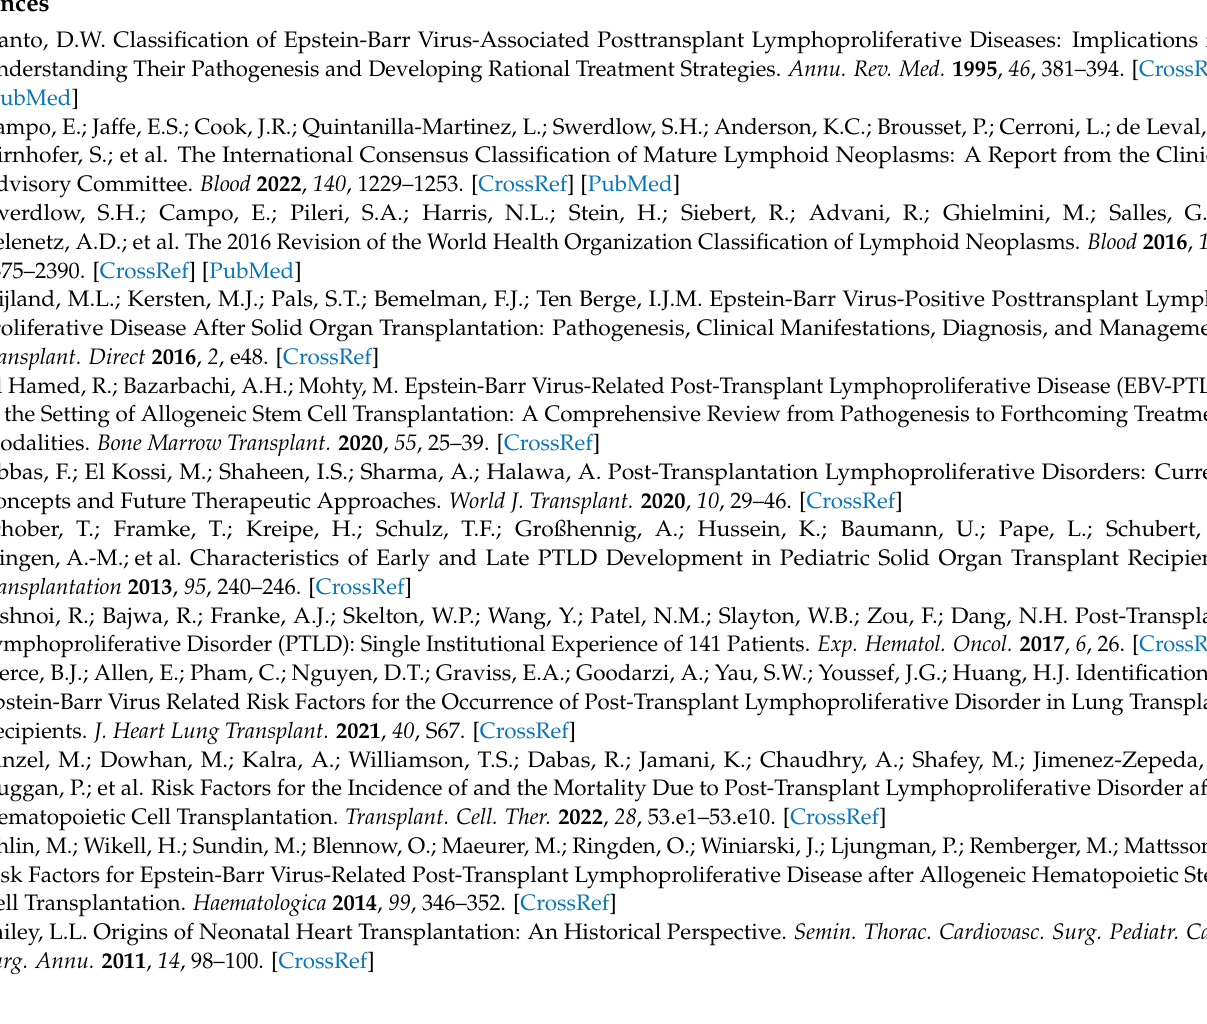
Figure S2: Effect of recipient and donor blood